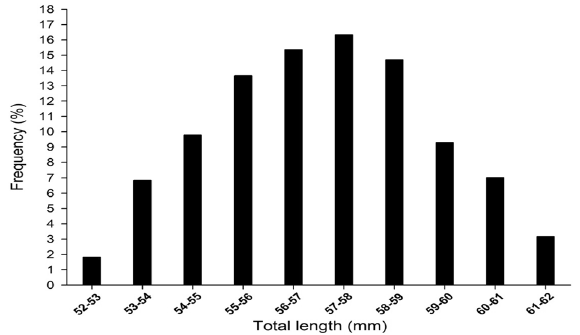
Figure 2. The frequency distribution map of the Japanese glass eel from